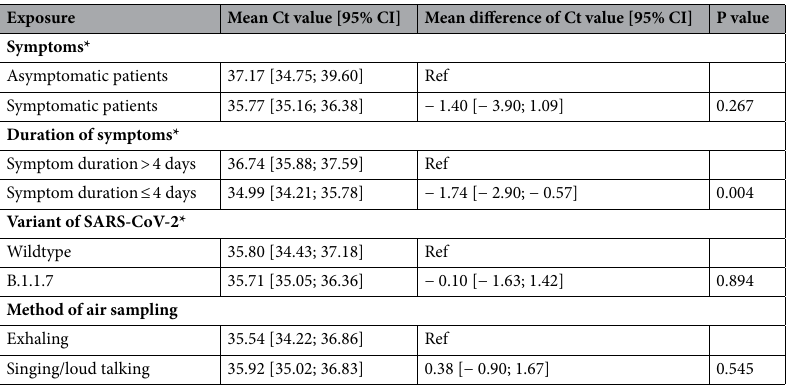
Table 3. Linear mixed-effect model analyses for Ct values stratified by exposures. Ct cycle threshold, CI confidence interval, IQR interquartile range, Ref reference, SARS-CoV-2 severe acute respiratory coronavirus 2. *Samples obtained through singing/loud